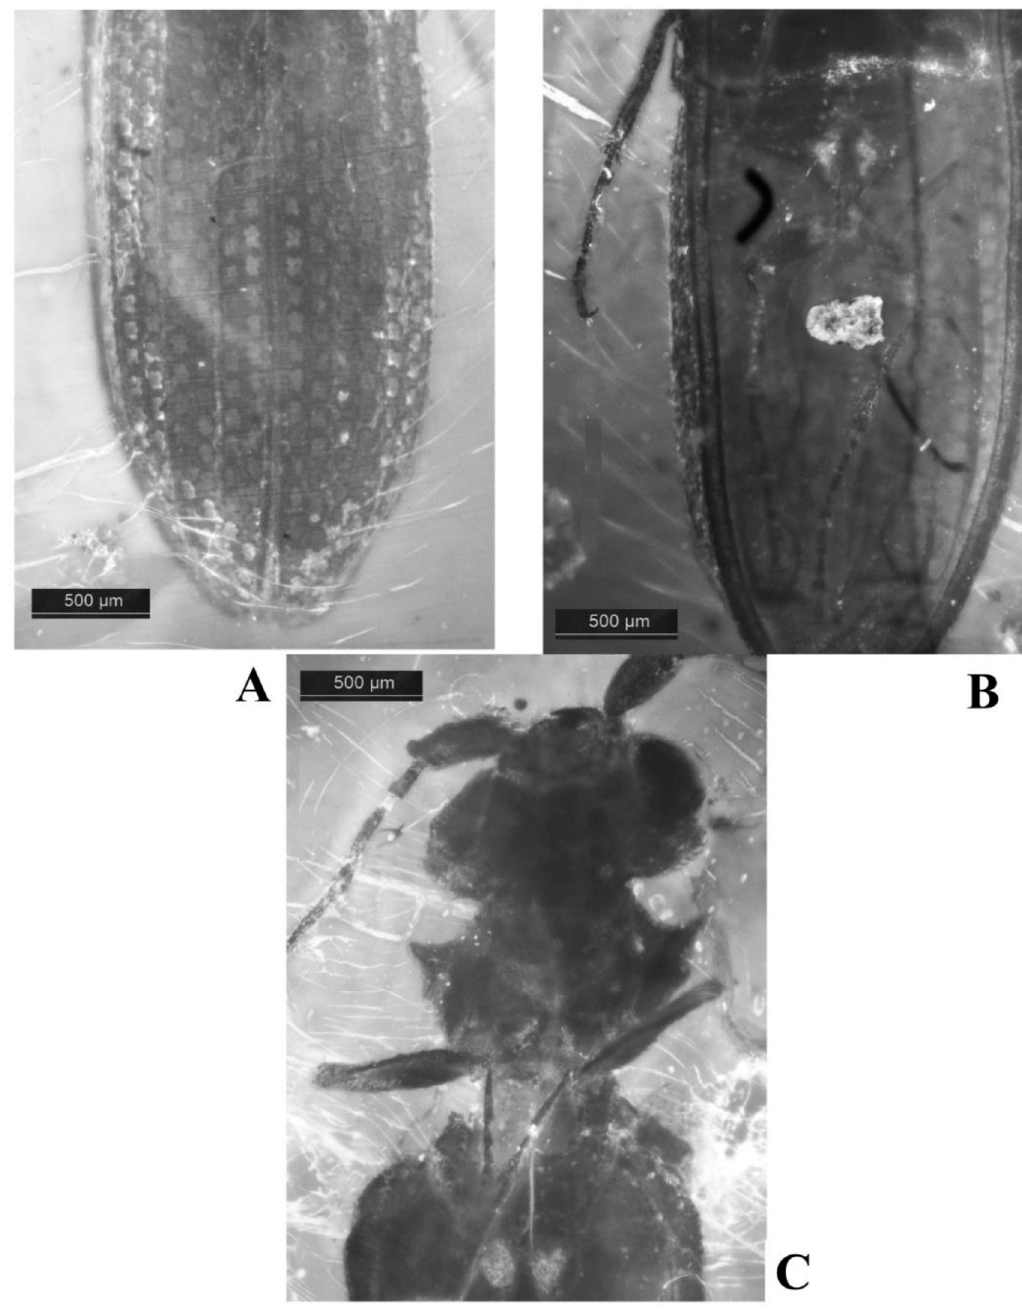
Figure 24. Cupedinae (Cupedidae). Mallecupes prokini sp. nov. , holotype, GPIH 4985, coll. Gröhn 11192 (Lower / Upper Cretaceous: Upper Albian / Lower Cenomanian; Myanmar, Kachin, Burmese amber); fluorescent microscopy with filter set N21: A —elytra, dorsal; B —distal part of metaventrite, elytra, right mesotibia and mesotarsus, posterior legs, ventral; C —head, prothora and mesothorax with appendages, ventral; length of inclusion 6.3 mm; scale for each picture provided; original. France: Oise (Le Quesnoy, Oise amber), Palaeogene, Lowermost Eocene, Ypresian, − 55.8–48.6 Note . See the above Notes to the genus Anaglyphites .